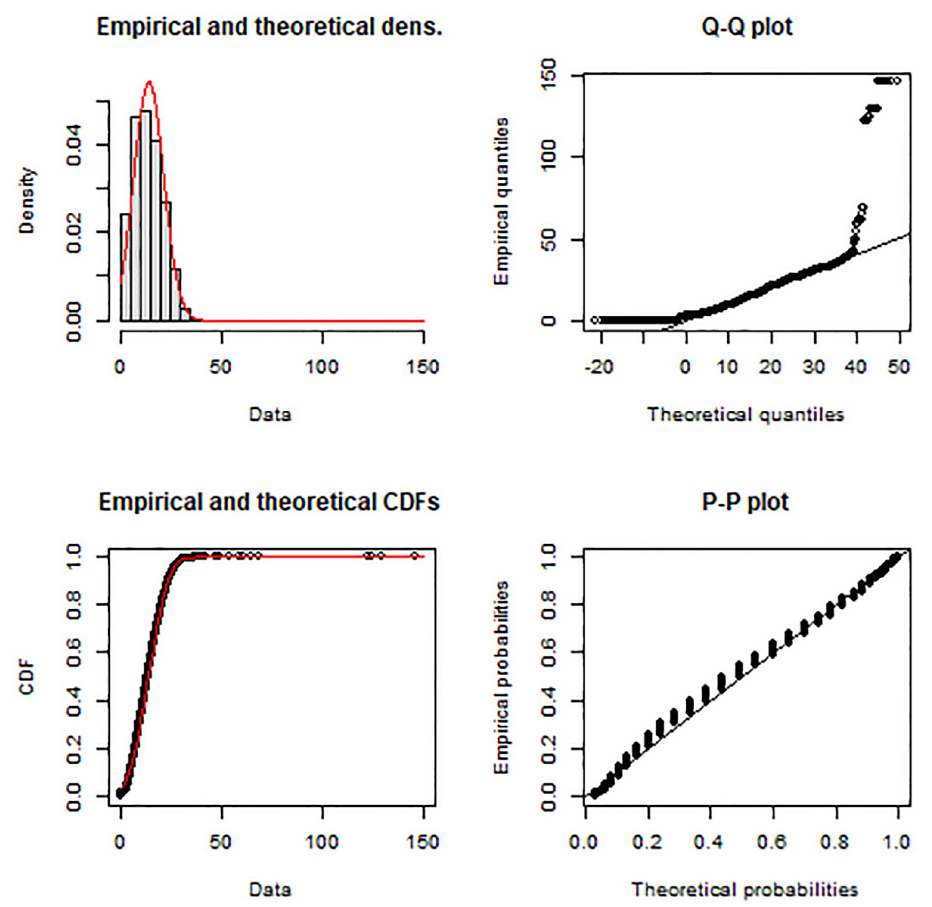
Fig 6. Car trip length distribution and calibrated normal distribution impedance function (red line) with associated Q-Q and P-P plots. Based on the estimated car travel times for full-time employment OD trips in Toronto from the TTS